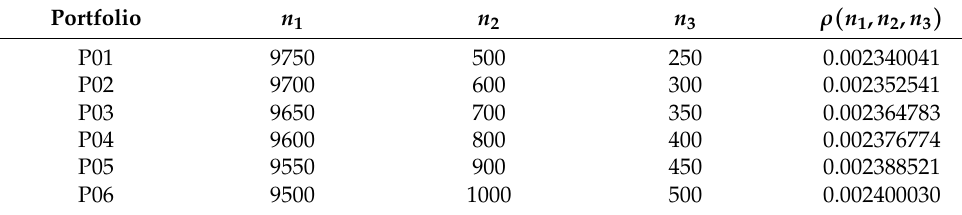
Table 5. Cases 1.4—Impact of the portfolio structure on the risk